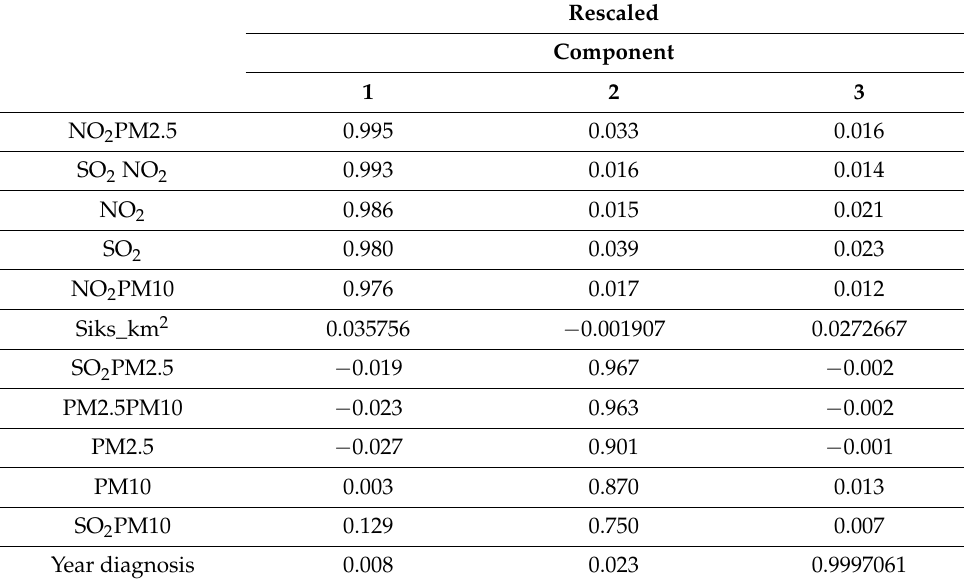
Table 3. Correlation between axis and variables (women squamous cell carcinoma).